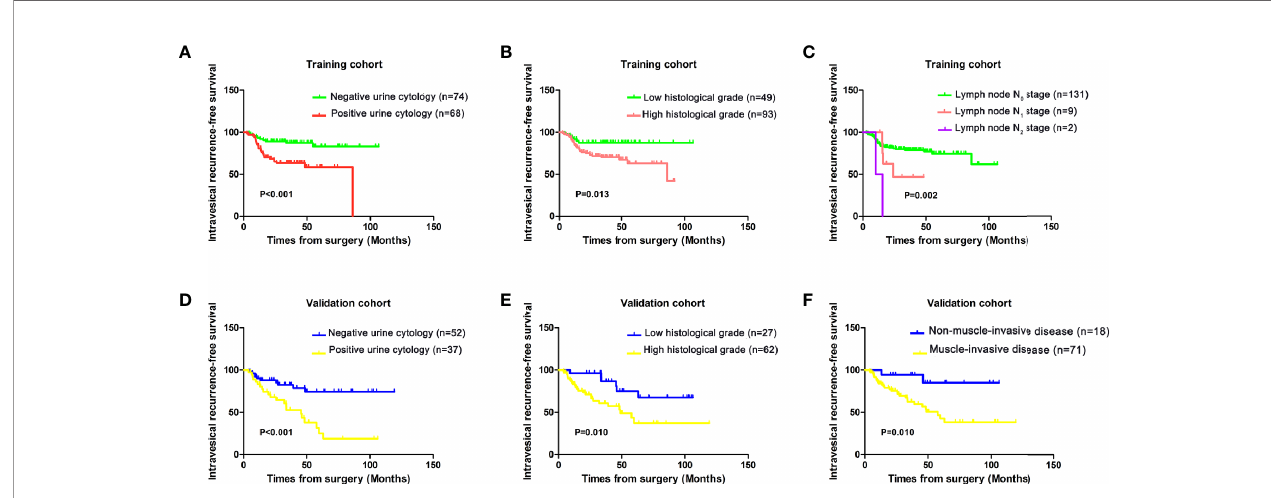
TABLE 3 | Univariate and multivariable Cox regression models predicting intravesical recurrence-free survival in 142 patients treated with RNU for UUT-UC in training cohort. Characteristic Univariate Multivariate HR P Value HR P Value Gender